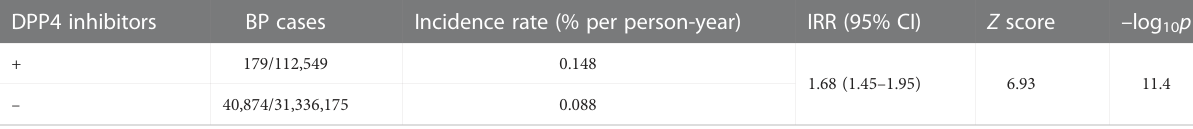
TABLE 3 Incidence rate ratio (IRR) of bullous pemphigoid (BP) with the prescription of DPP4 inhibitors based on MarketScan data. DPP4 inhibitors BP